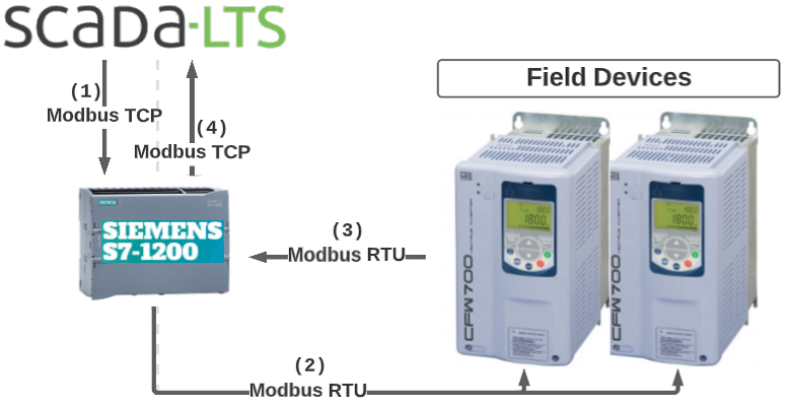
Figure 15. Schematic of the communication between ScadaLTS and frequency converters. Source: Cagepa,